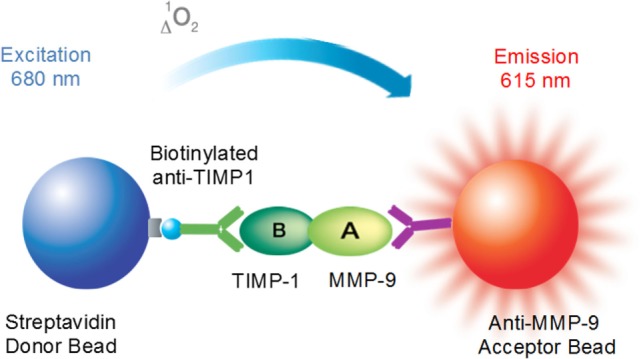
Principle of the AlphaLISA® matrix metalloproteinase (MMP)-9–tissue inhibitor of metalloproteinase (TIMP)-1 interaction immunoassay.